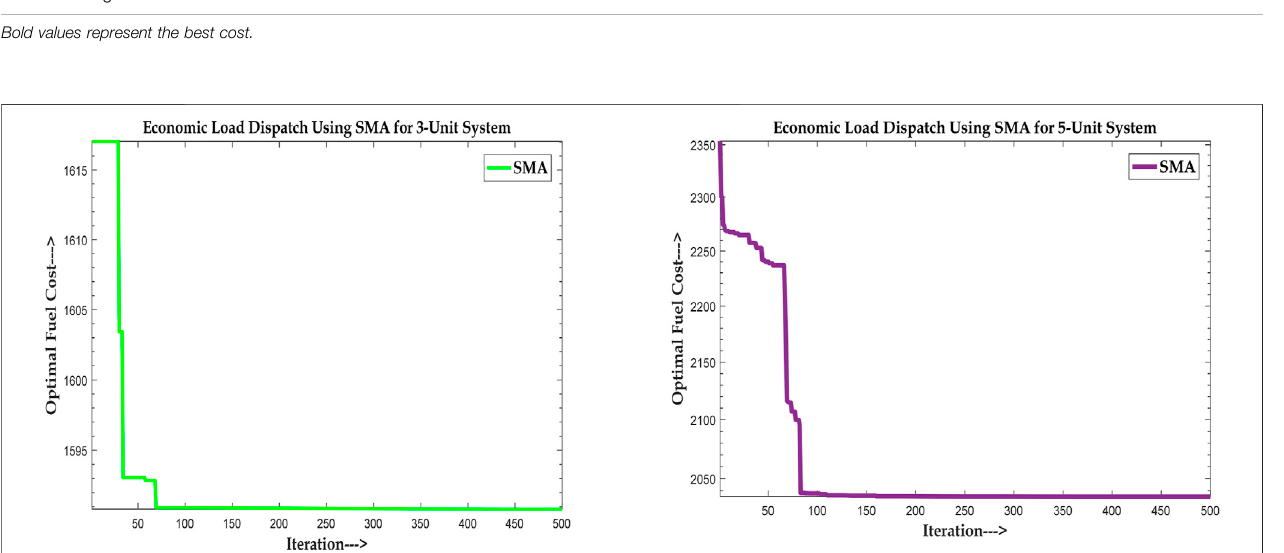
FIGURE 2 | Convergence curve for 3 and 5-generating units system.